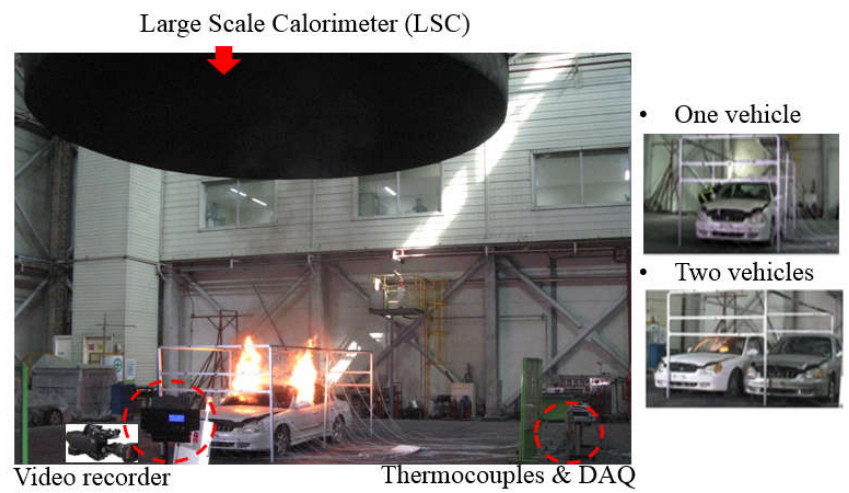
Figure 3. Experimental setup and measurement tools.